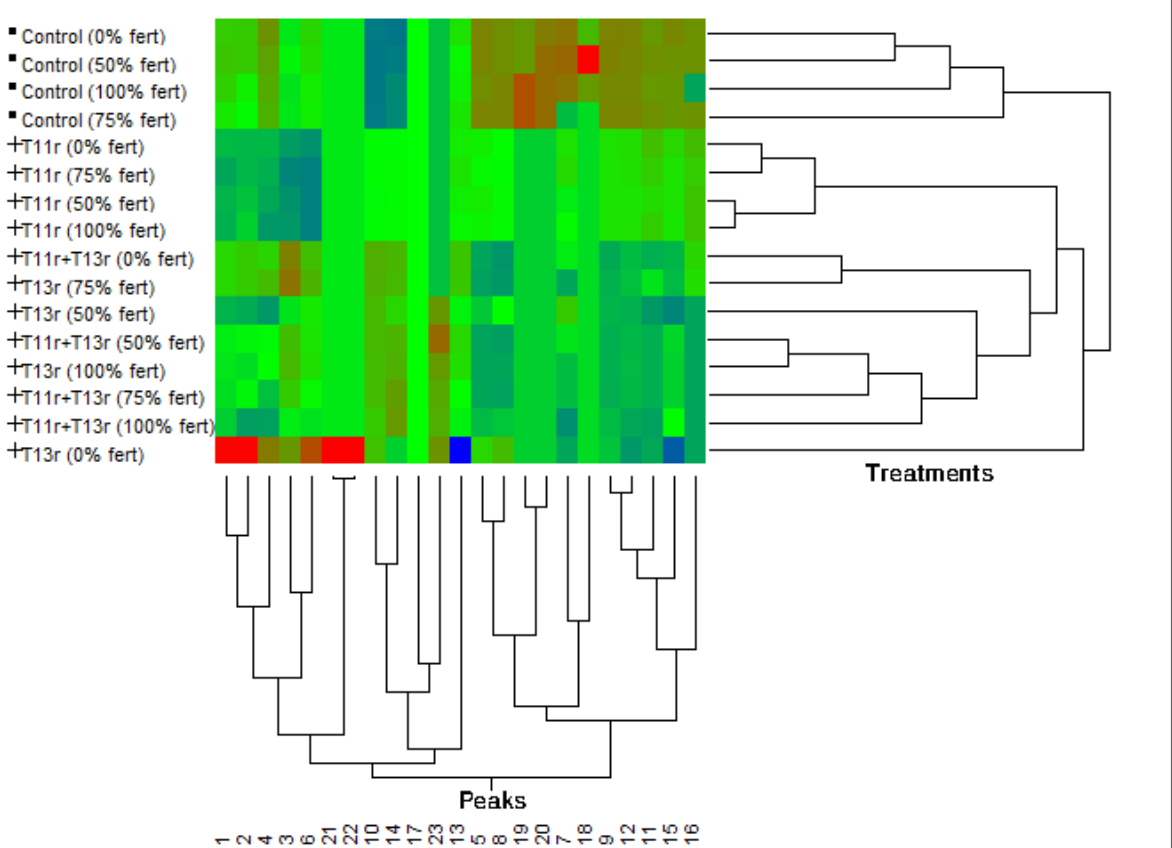
Figure 6: Two-way cluster analysis to group the different treatments into a number of clusters based on the observed values of the compounds and their percentages existing in the extracted oil from T. vulgaris plant treated or not with bacterial endophytes (T11r, T13r, and their consortium) under different mineral fertilization doses. The description of each peak number is listed in Table